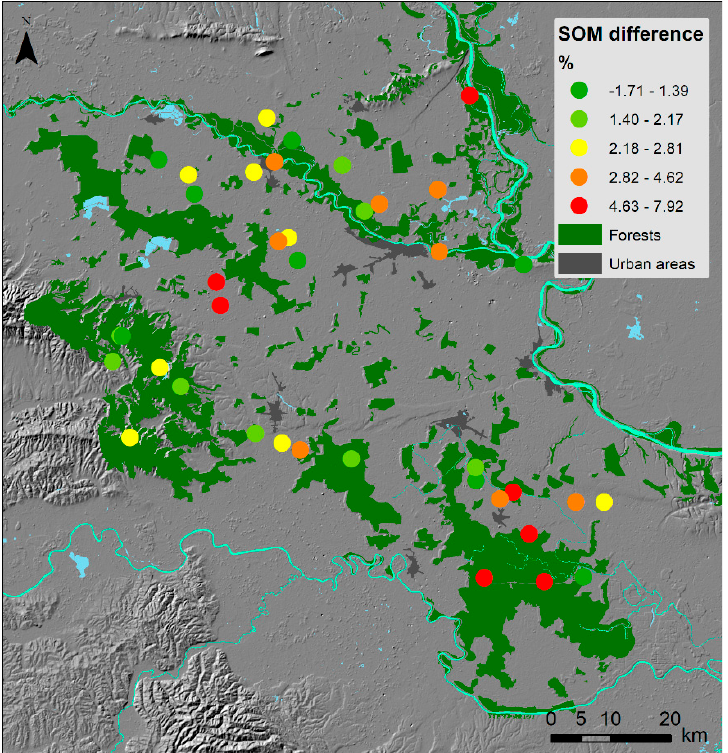
Figure 10. Map of differences between SOM1970 and SOM2010 interpolated values with classes according to quantile classification. Interpolated SOM2010 values with a prediction standard deviation higher than 50% of computed differences have been excluded.